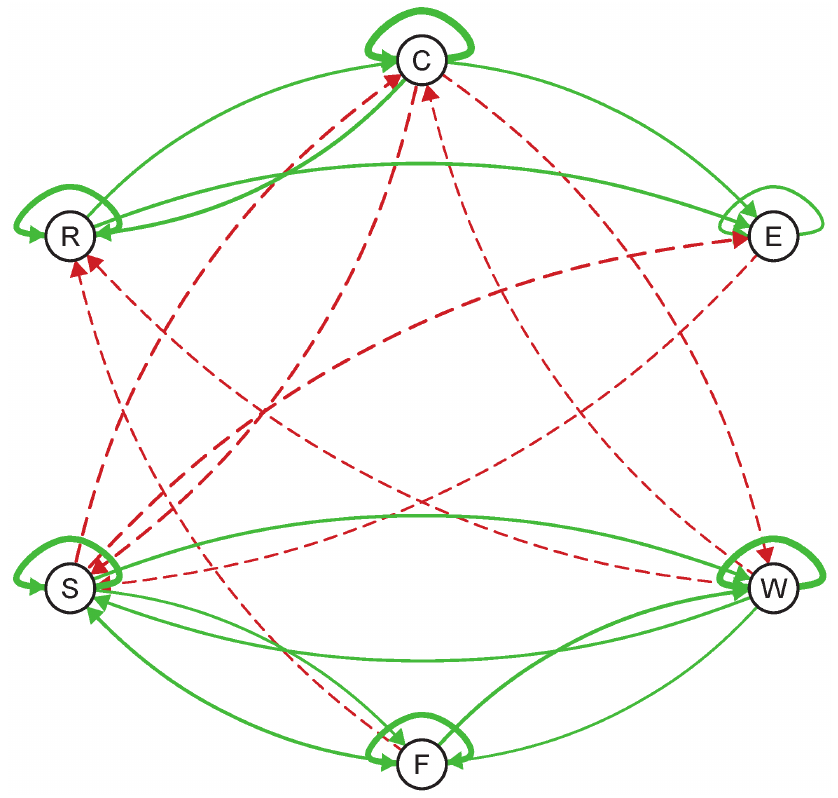
Figure 1. Estimated population network at baseline. The six items are: C=cheerful, E=pleasant event, W=worry, F=fearful, S=sad and R=relaxed. Solid green arrows correspond to positive connections and red dashed arrows to negative connections. Only arrows that surpass the significance threshold are shown (i.e., for which the p-value of the t-statistic is smaller than 0.05). Arrows can be either red, indicating a negative relationship (i.e., b kj v 0 ), or green, indicating a positive relationship (i.e., b kj w 0 ). Furthermore, the strength of the relation from item k to item j (i.e., an extremer value for b kj ) is translated into the thickness of the arrows: the thicker the arrow between two nodes, the stronger the nodes or items are related. Note that item responses can also be predicted from the previous state of the item itself. These arrows are the self-loops in the network.